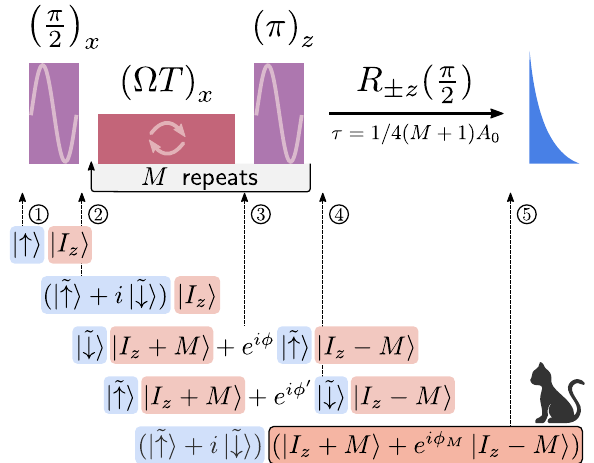
FIG. 5. Preparation of a Schrödinger kitten state. The quantum state preparation sequence closely resembles that of the elemen- tary unit of our feedback algorithm [Fig. 2(a)], but with two modifications. Firstly, a ð π Þ z rotation of the electron after the actuate gate allows us to repeat actuation M times for the excitation of M magnons. Secondly, the wait time between actuation and reset is now precisely chosen to perform a ð π = 2 Þ rotation about the z axis conditional on the nuclear state, R ð π = 2 Þ . Markers 1 – 5 track the quantum state evolution during (cid:3) z the preparation sequence. The relative phase ϕ comes from evolution under the nuclear Zeeman and hyperfine terms and, while precisely known, is